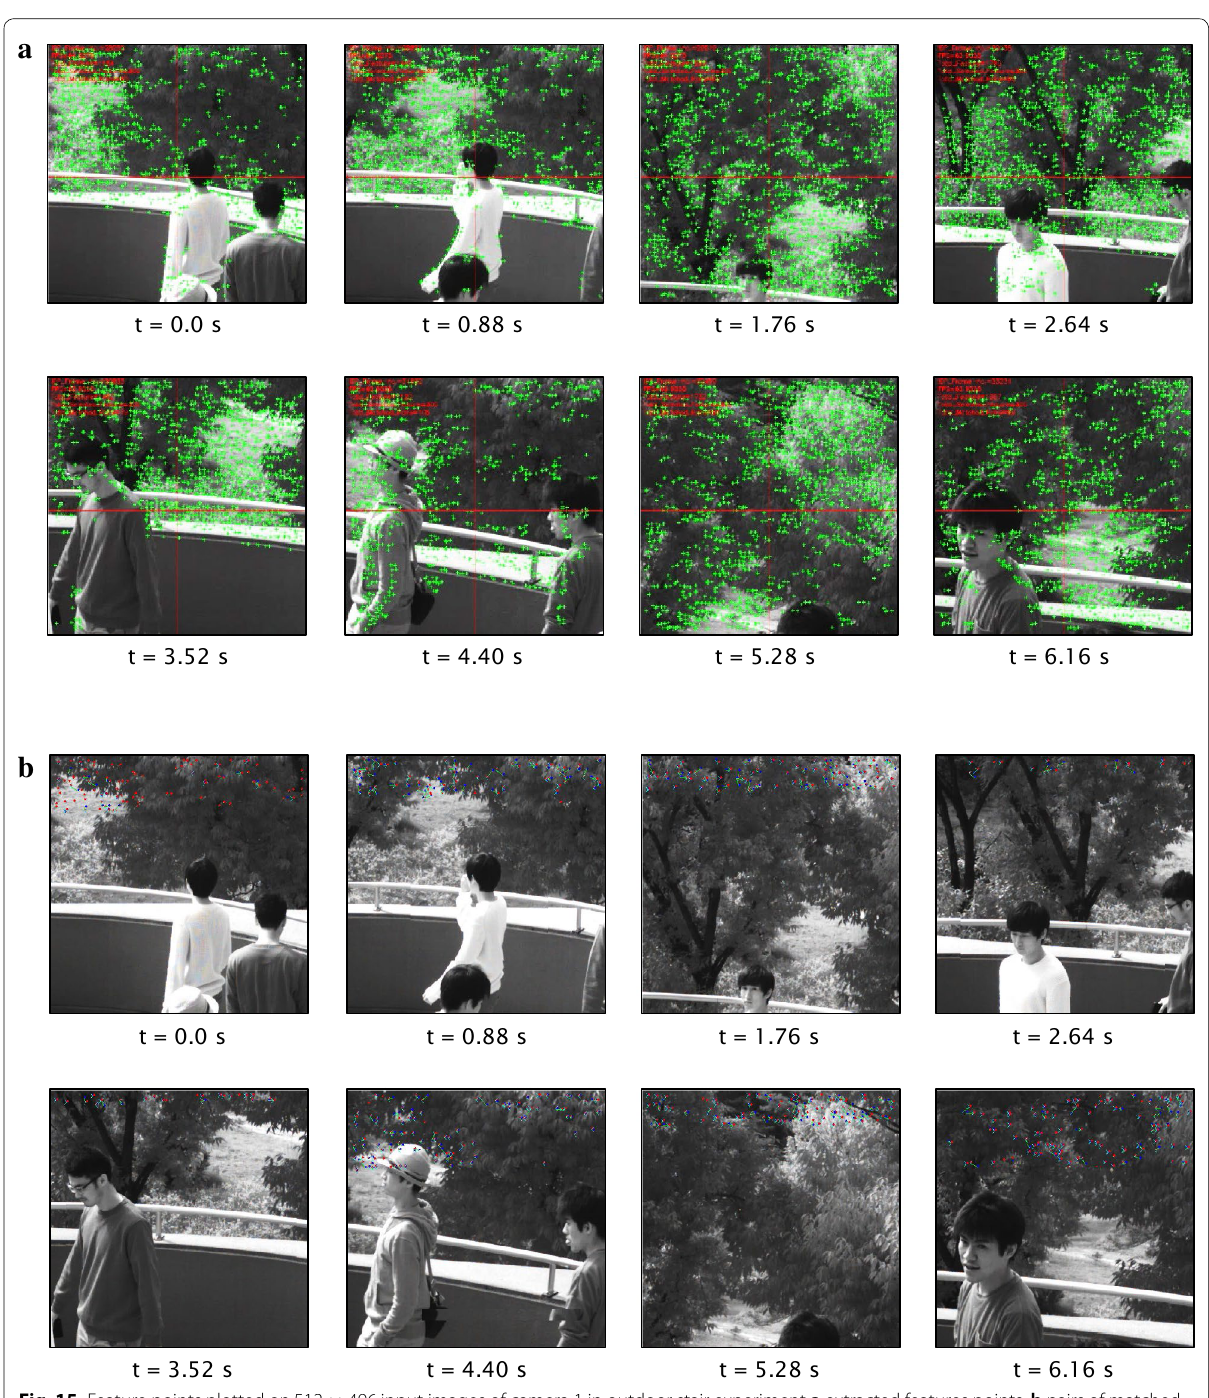
Fig. 15 Feature points plotted on 512 × 496 input images of camera 1 in outdoor stair experiment a extracted features points, b pairs of matched feature